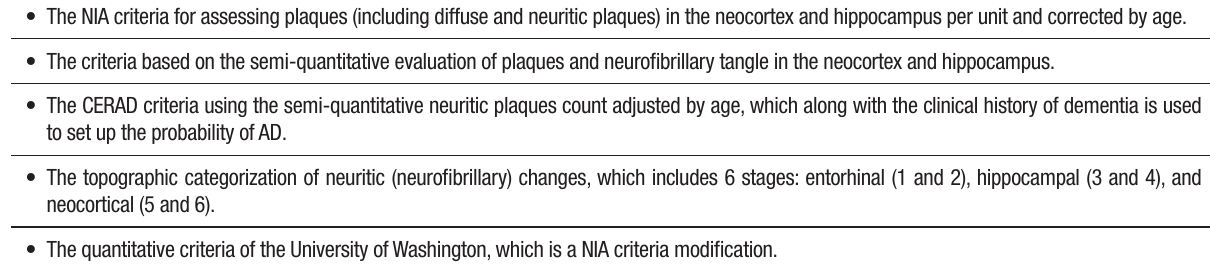
Table 1. Rules for the pathological diagnosis of